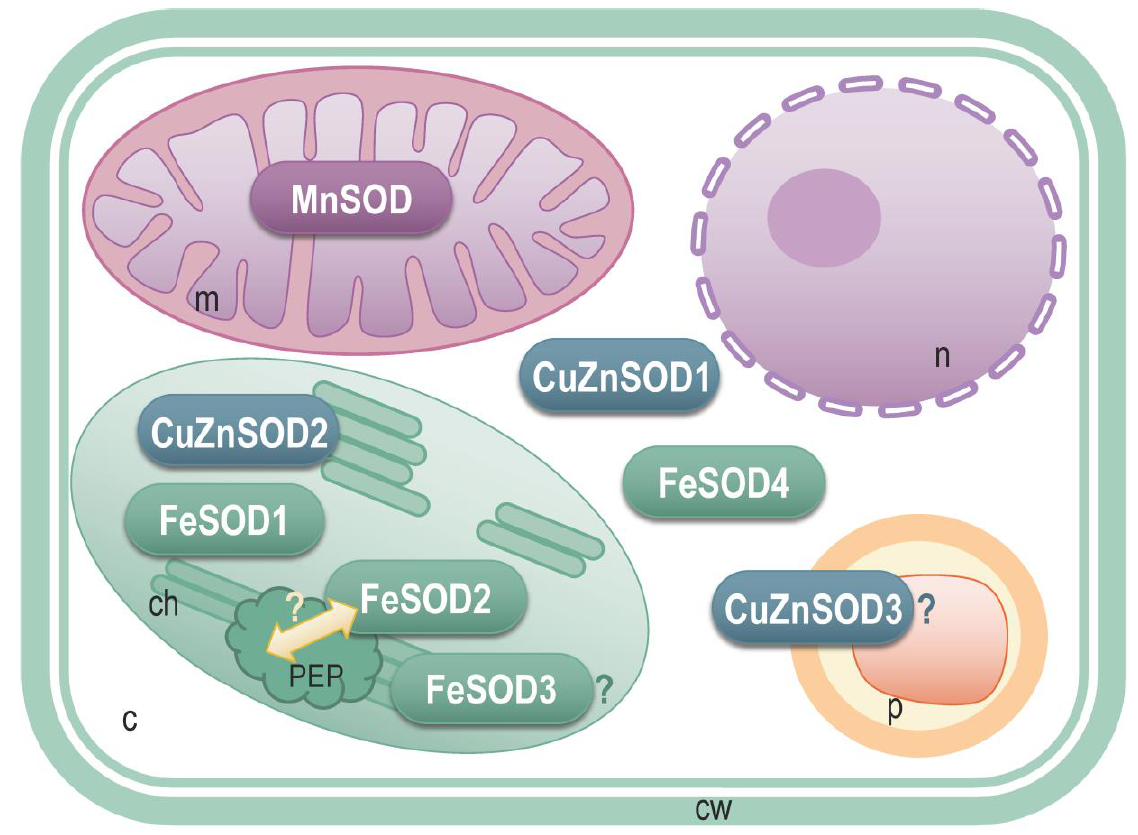
Figure 8. Proposed subcellular localization of StSODs. Prefix “St” is omitted from the potato SOD isoform names for simplicity. C—cytosol; m—mitochondrion; ch—chloroplast; p—peroxisome; n—nucleus; cw—cell wall; PEP—plastid-encoded RNA polymerase. Inconclusive localizations of certain isoforms as well as unproven interactions are indicated by a question